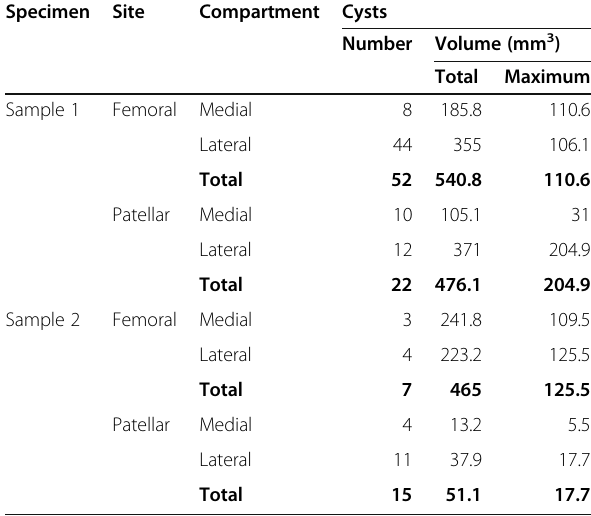
Table 2 Quantitative analysis of the bone cysts for two of the